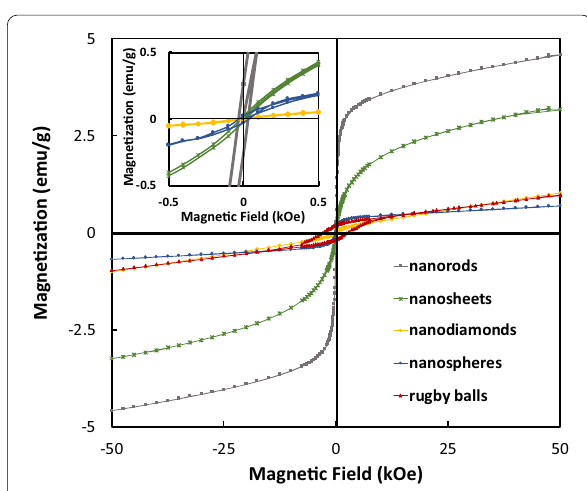
Fig. 3 Magnetization curves at 300 K from -50 kOe to -50 kOe for the hematite nanorods (grey squares), nanosheets (green asterisks), nanodiamonds (yellow diamonds), nanospheres (blue spheres), and rugby balls (red triangles) shaped